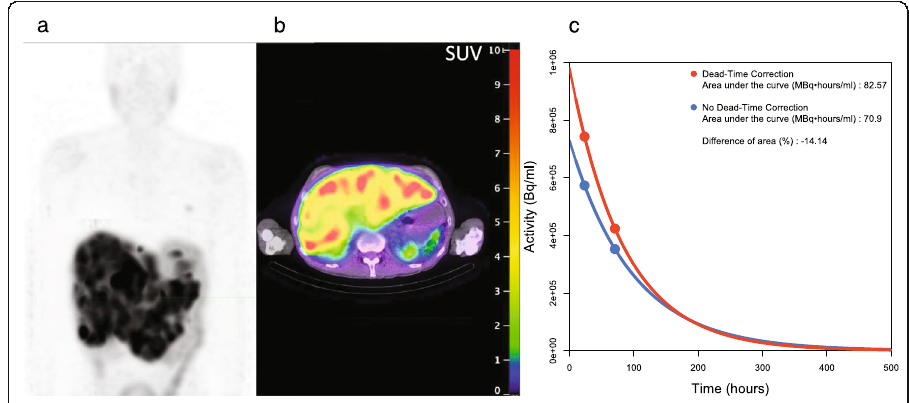
Fig. 3 Day3 QSPECT maximum intensity projection ( a ), fused QSPECT/CT slice ( b ) and renal time-activity concentration curve ( c ) of a patient with extensive liver metastases who received 28.9GBq 177 Lu-octreotate at his second cycle. The dead time was 22.8% and 16.8% on day 1 and day 3 QSPECT, respectively. The area under the curve – and consequently, the renal absorbed dose – would have been underestimated by 14.1% without dead-time correction